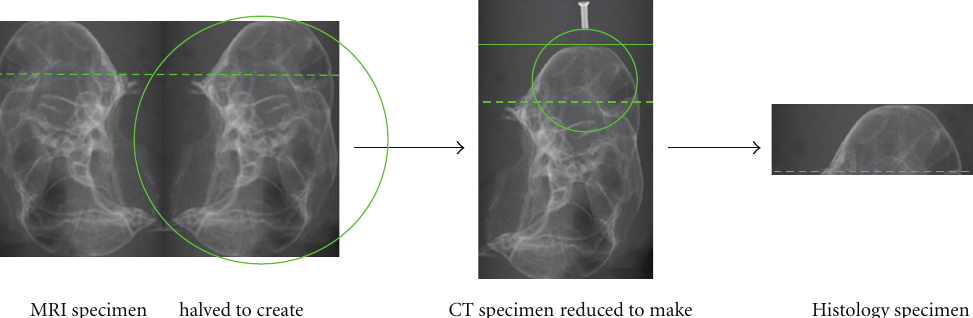
Figure 1: Description of specimen use. Each specimen began with a complete chinchilla skull, which was used for MRI imaging. Due to the size limitation of samples in the Micro-CT machine, chinchilla skulls were halved to accommodate CT imaging. Once imaging was completed, samples were further pared down to about one quarter of their original size for histology processing. Histology cassettes and molds limited the size of the sample.